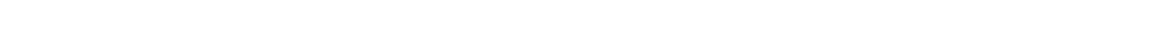
Frontiers in Energy Research | Carbon Capture, Storage, and